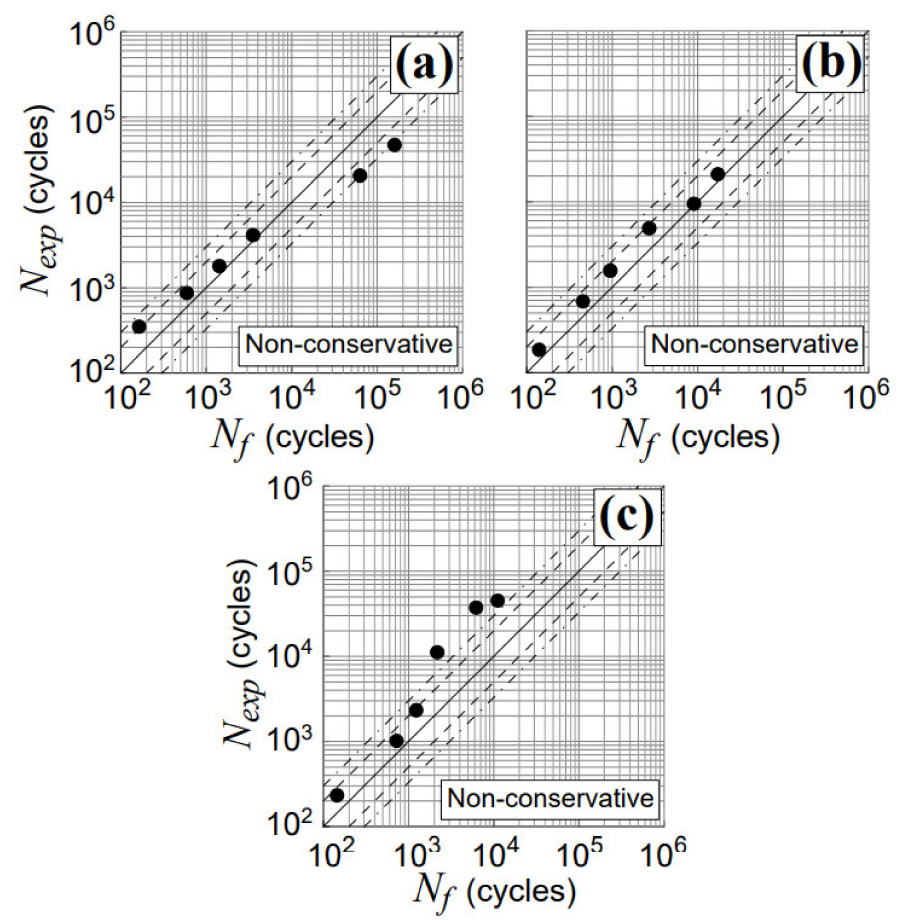
Figure 12. Experimental and estimated lifetime of TC4 titanium alloy obtained using the refined equivalent deformation criterion for tests: ( a ) Nos. T1–T6, ( b ) Nos. T7–T12, and ( c ) Nos. T13–T18, in Table 2.